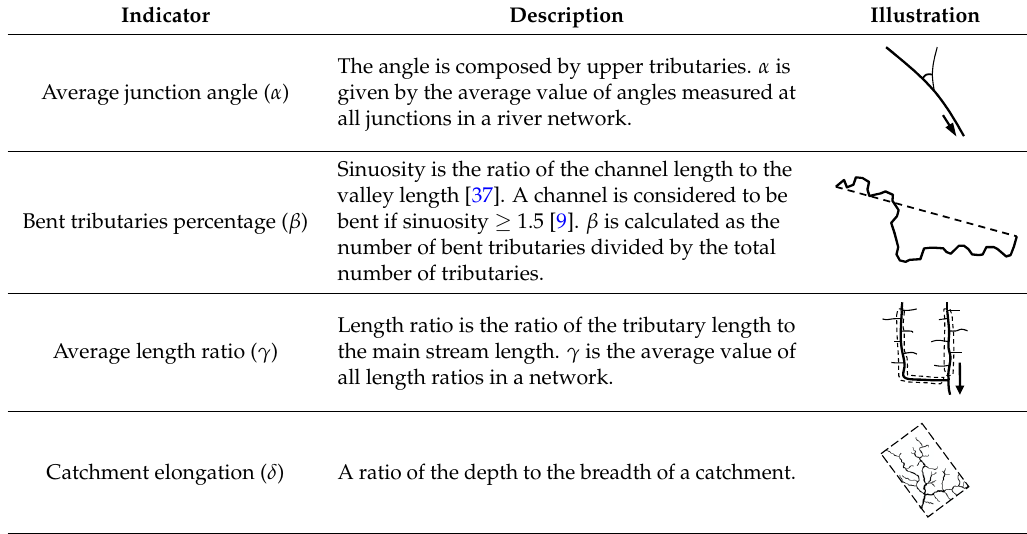
Table 1. List of geometric indicators.